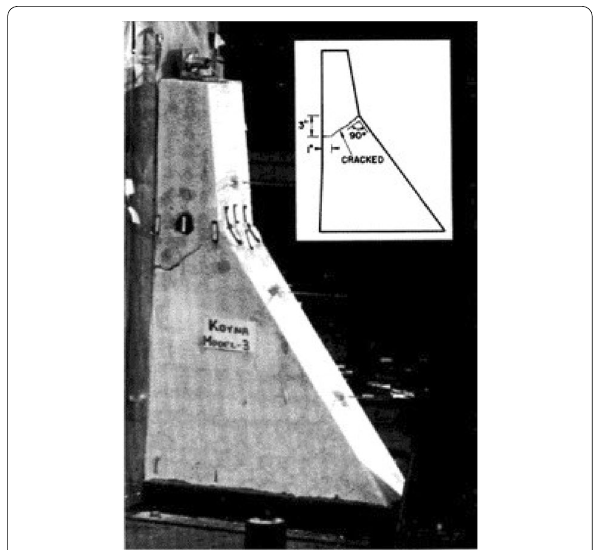
Fig. 27 SDV5 nephograms of the Koyna gravity dam with the longitudinal crack at different times: a t t 2.65 s, f t 2.92 s, and g t = =